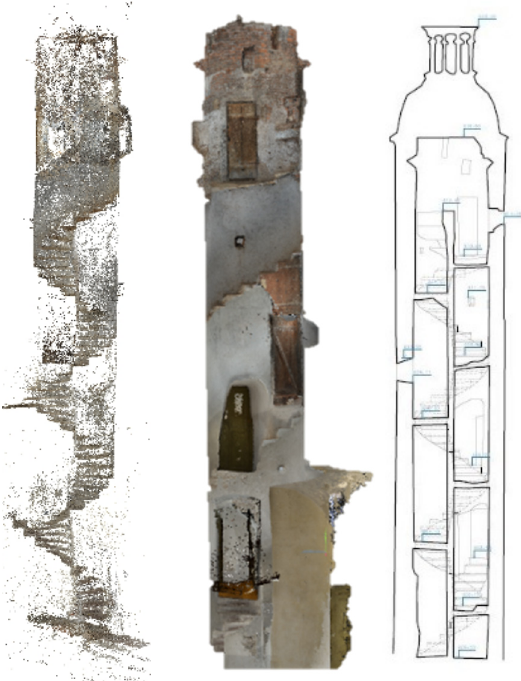
Figure 10. From left to right: Tie point cloud (PS sw), dense cloud (RC sw) and 2D draw of vertical model